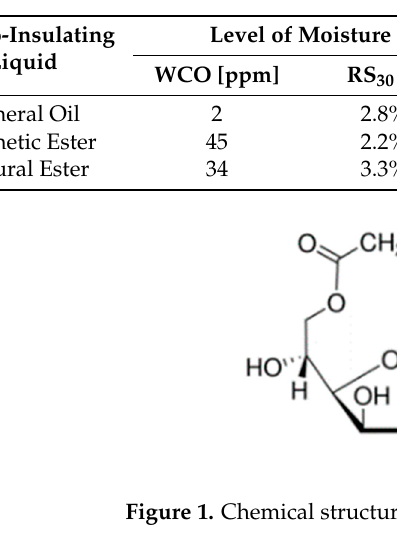
Table 2. Moisture levels and acid numbers of the electro-insulating liquids used.